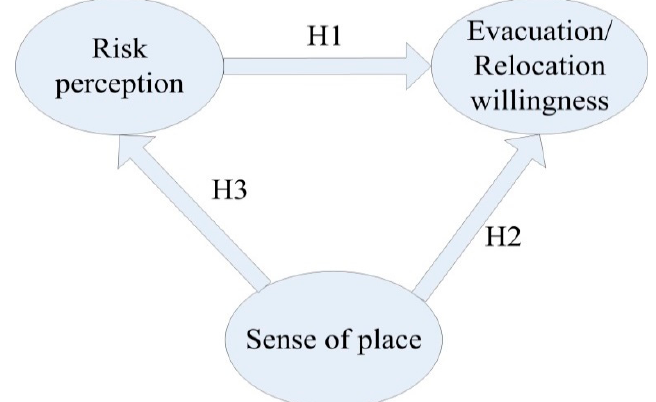
Figure 2. Research hypothesis framework.